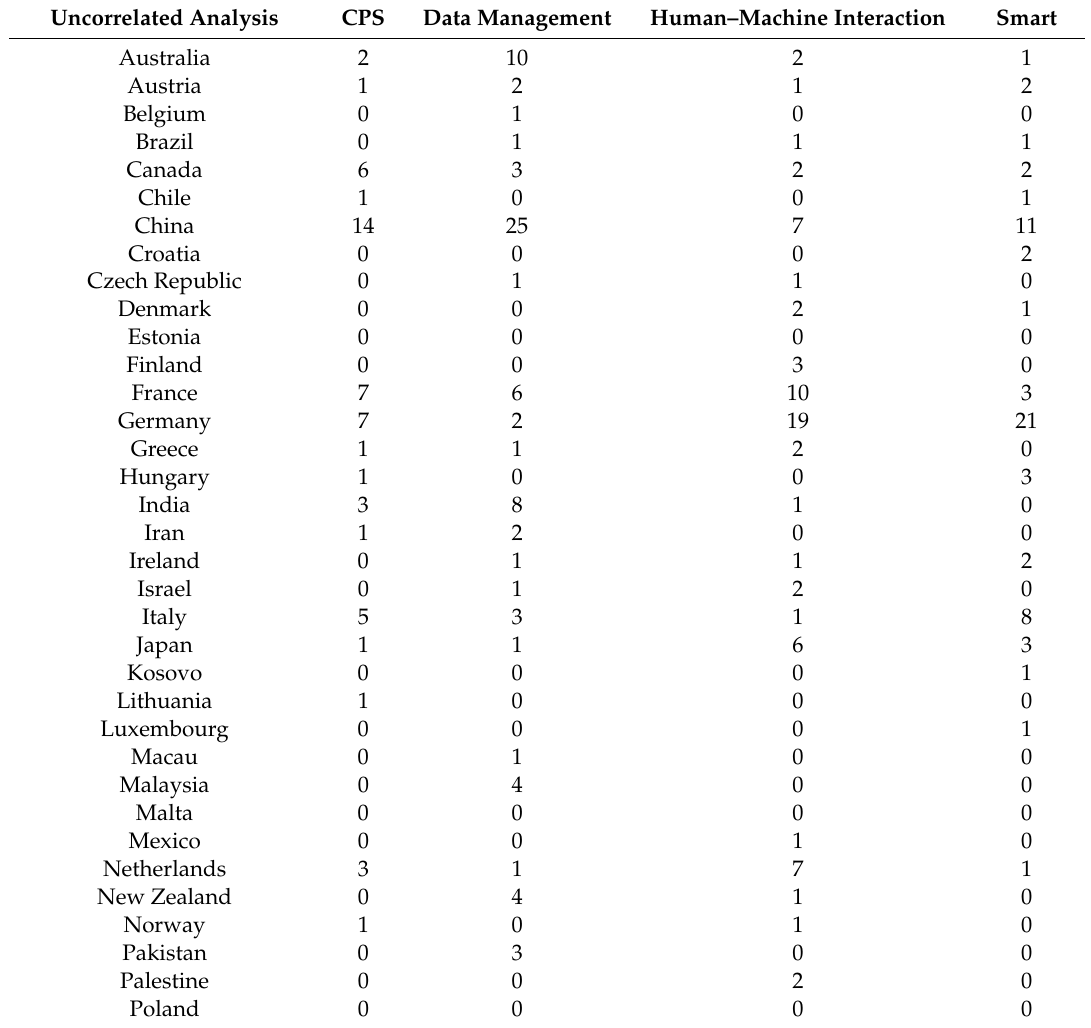
Table A1. Number of papers identified in the uncorrelated international analysis. Uncorrelated Analysis